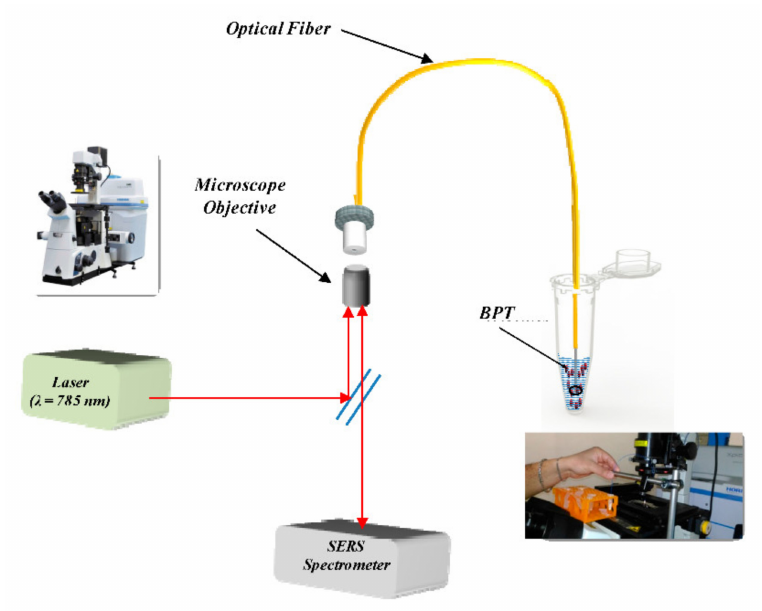
Figure 15. Schematic of the experimental setup of the SERS optical fiber sensor based on back scattering mode. The optical fiber probe is immersed in the BFT solution. Reprinted from Ref. [93]. Recently, Gu et al. [95] proposed a seed mediated growth of AuNPs monolayer on a fiber facet for ultrasensitive in-situ SERS detection of methylene blue (MB), CV and R6G up to 10-9 M with the experimental set up shown in Figure 16 [95].